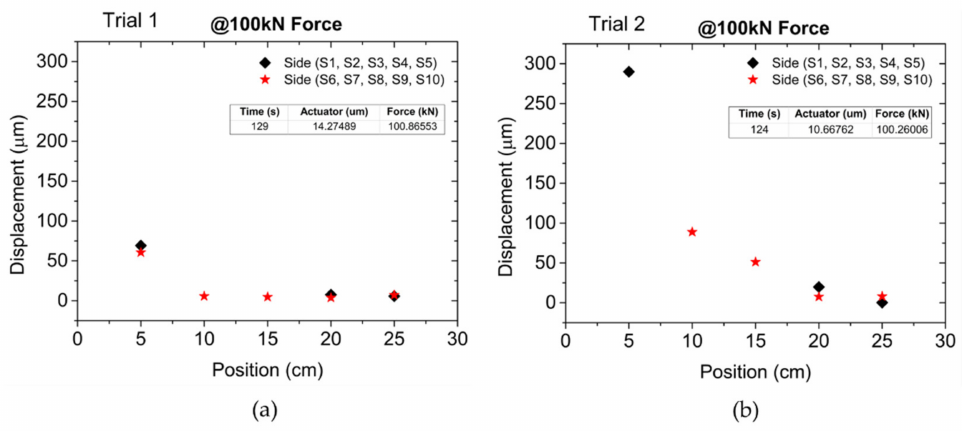
Figure 9. RB displacement measured by each sensor at 100 kN of pull-out force: ( a ) In Trial 1. ( b ) In Trial